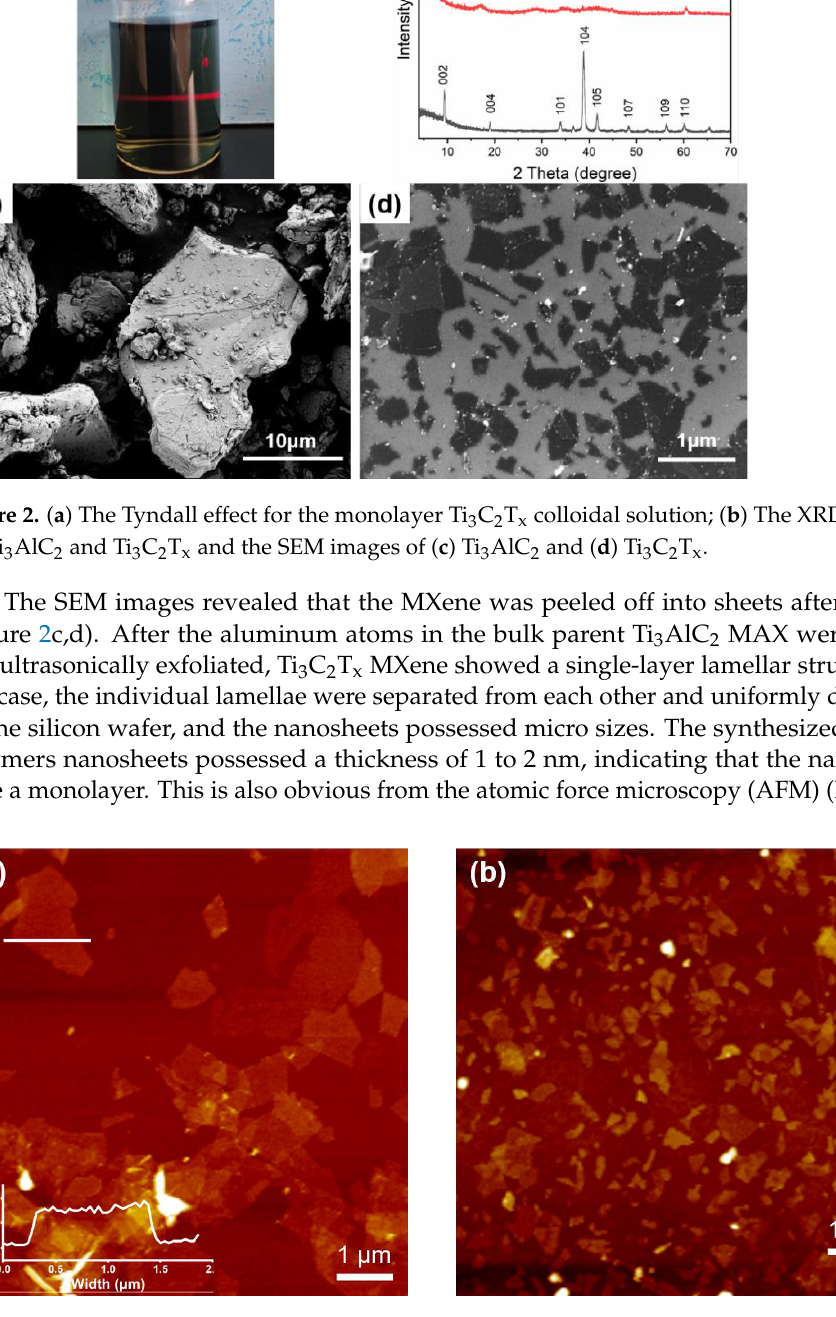
Figure 4. ( a ) The XPS results of the Ti 3 C 2 T x MXene nanosheets obtained with ultrasound for 60 min; ( b – d ) The XPS results of the Ti 3 C 2 T x MXene nanosheets obtained with CU-CS; ( e ) The FTIR spectra for Ti 3 C 2 T x MXene. 3.2. Effect of the Ultrasonic Method on the Size and Yield of the Nanosheets The time of sonication influenced the size of the nanosheets. In the current research work, the effect of continuous ultrasonic time on the size of the nanosheets was deter- mined. As shown in Figure 3, the nanosheets prepared after continuous ultrasound for 60 min possessed a few hundred nanometers. The one prepared using an ultrasonic treat- ment of 10 min exhibited the micro sizes. This may be because the mechanical stability of single-layer nanosheets is insufficient for long-term ultrasonic treatment. The collision